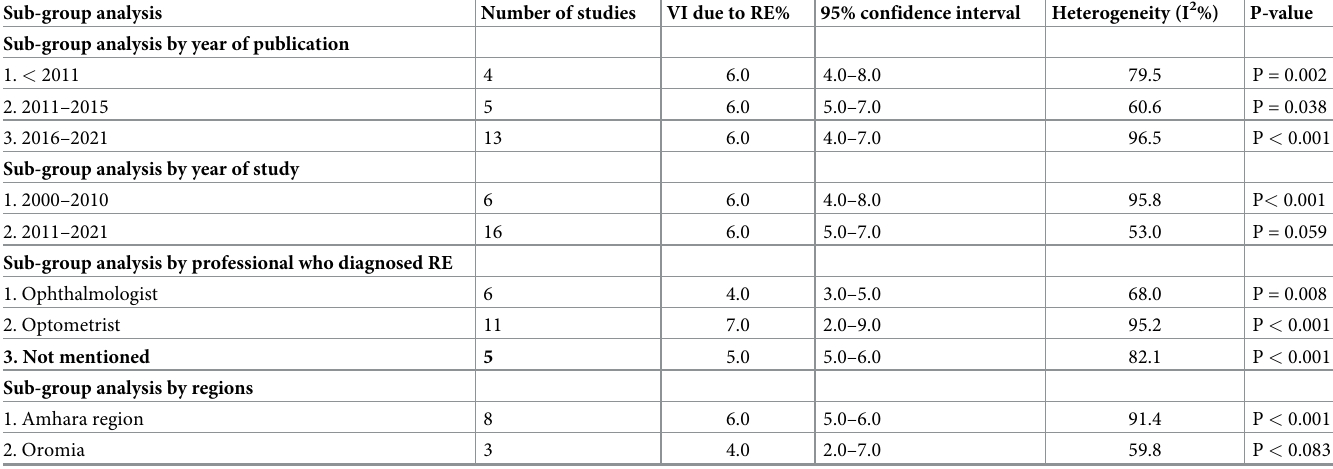
Table 2. Sub-group analysis by region, year of publication, year of study, professional diagnosed RE, study setting, and sample size on the prevalence of visual impairment due to RE in Ethiopia,